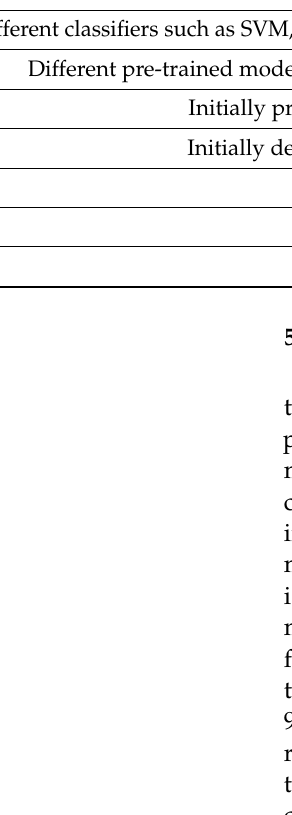
Figure 15. Training loss on 3-fold, 5-fold and 10-fold cross validation.